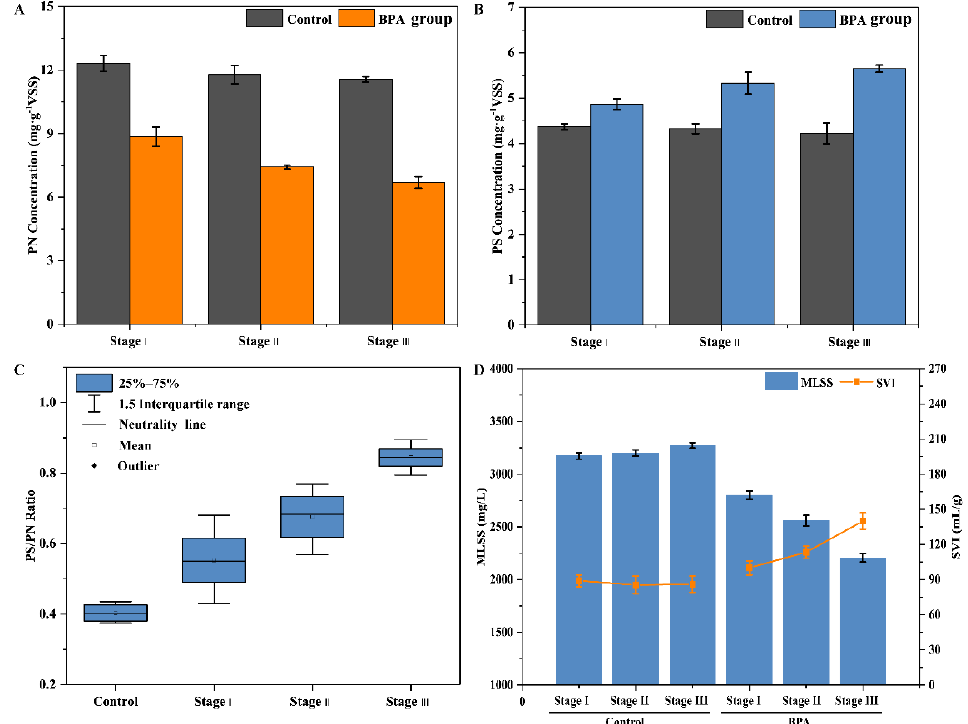
Figure 1. Effects of bisphenol A (BPA) on extracellular polymeric substances (EPSs) and the settling properties of activated sludge. ( A ). Change in protein content in EPS; ( B ). Change in polysaccharide content in EPS; ( C ). Ratio of polysaccharide to protein in EPS; ( D ). Sequencing batch reactor (SBR) sludge concentration and the ratio of SV (mL) to sludge dry weight (g) (SVI). MLSS: mixed liquid suspended solids.